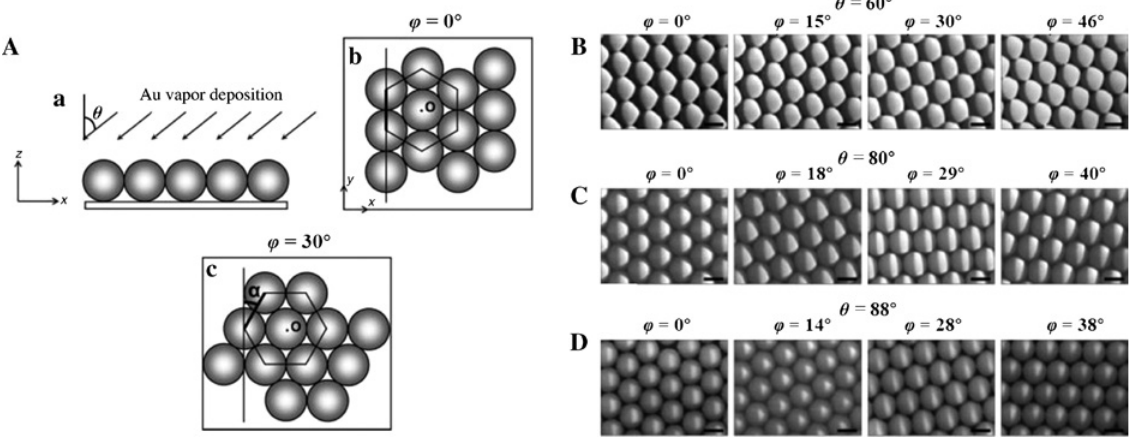
Figure 6: Patchy particles fabricated by single